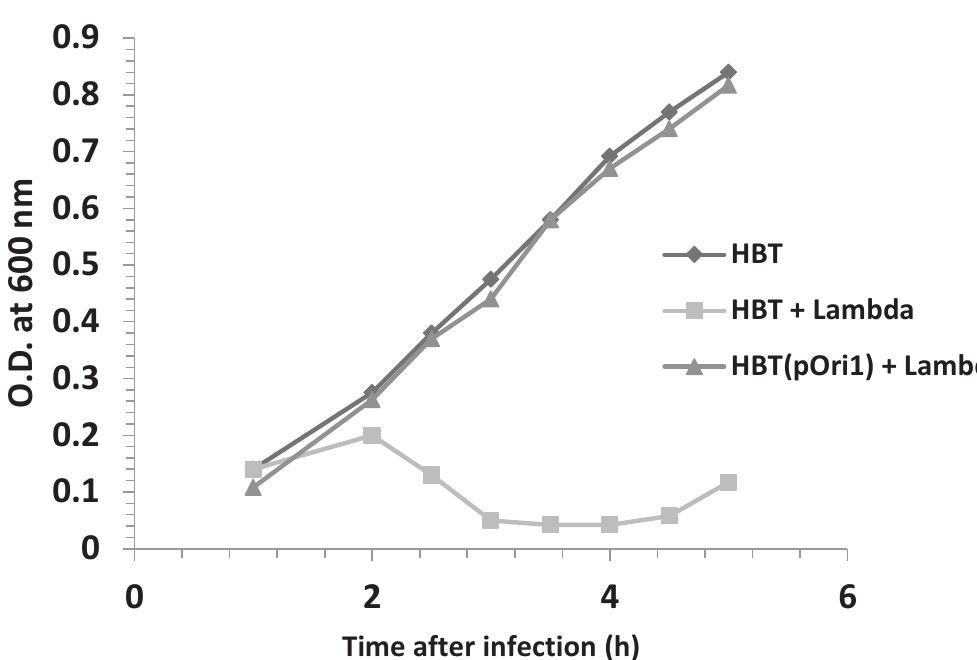
Figure 1. Effect of harboring ectopic copies of λOri on the growth profile of HBT after λ infection. The turbidity at OD 600nm of HBT, an E. coli K12 thy − derivative of HB101(recA13, leu, pro), and that of its derivative HBT(pOri1) harboring the plasmid pOri1, were determined at indicated times following λ infection. The growth profile of an uninfected HBT culture was also determined and is shown as a control.